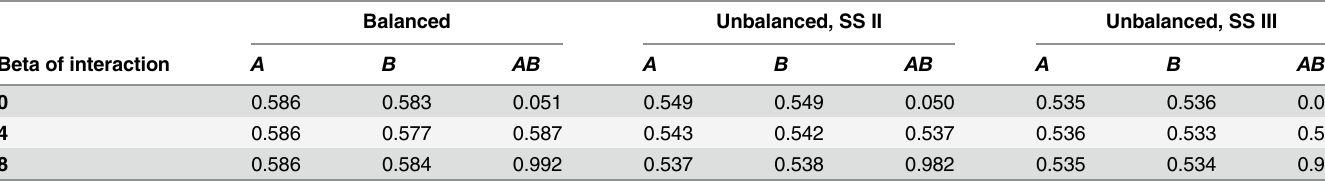
Table 5. Mean rejection rates of H0 (congruous data